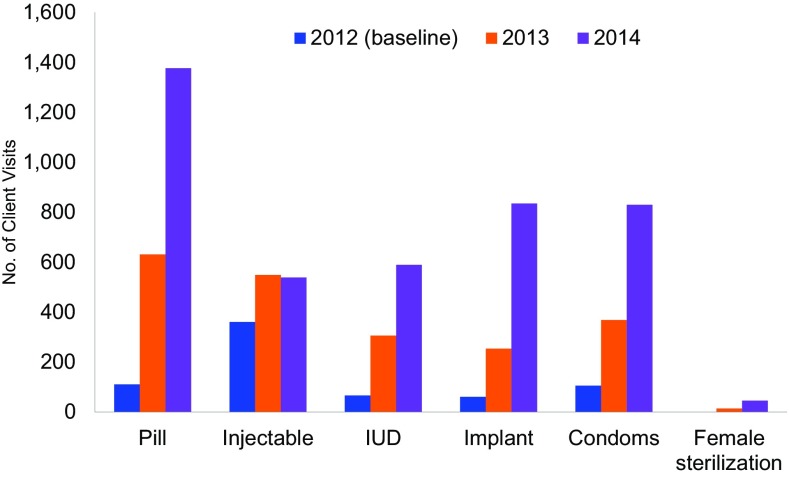
Total Client Visitsa by Family Planning Method at Dophil and Namasoli Health Facilities, Kenya, Phase 1Abbreviation: IUD, intrauterine device.aIncludes new and returning client visits.